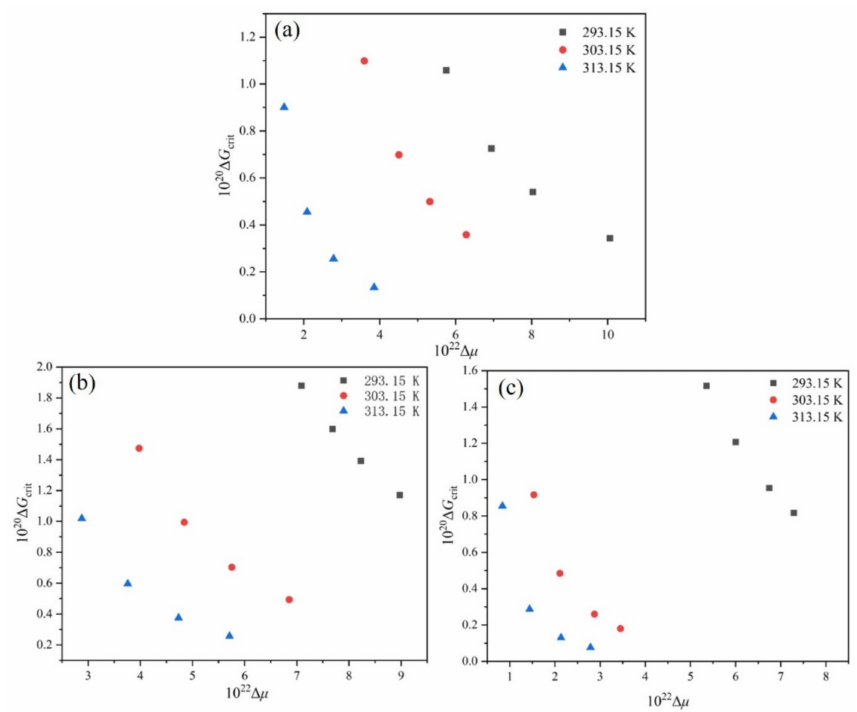
Figure 11. Relationship between ∆ G crit and ∆ µ at different T 0 : ( a ) ethanol mass fraction of 0.6,